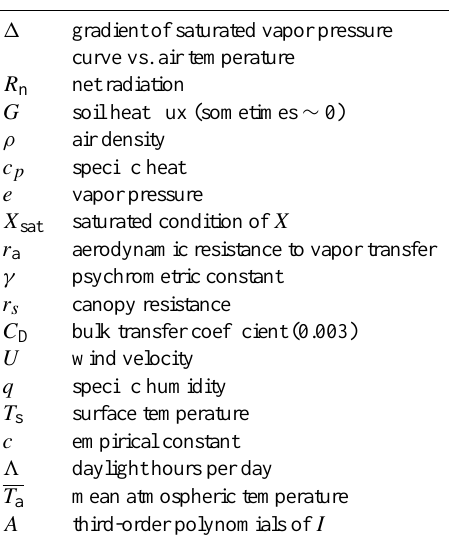
Table A1. The symbols used in the potential evapotranspiration for-